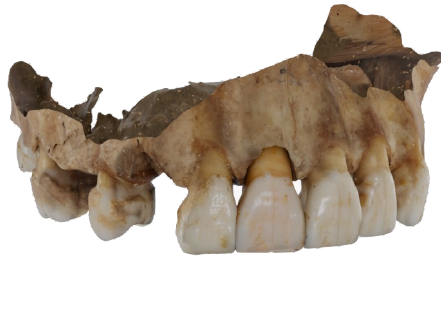
Figure 9. 3D reconstruction of the lost